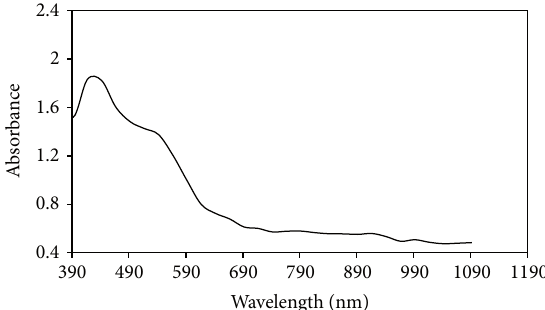
F 6: UV spectrum showing the formation of product at 437nm in low catalyst concentration aer the decomposition of intermediate complex at 534nm.